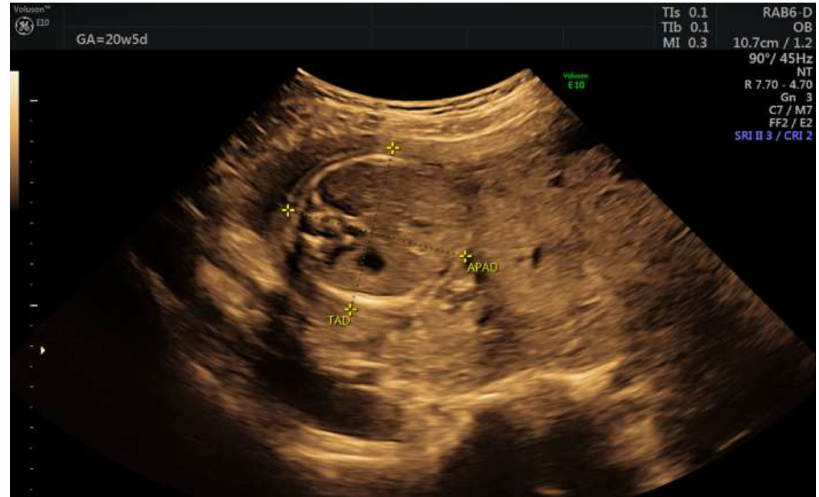
Figure 1. Placentomegaly with severe